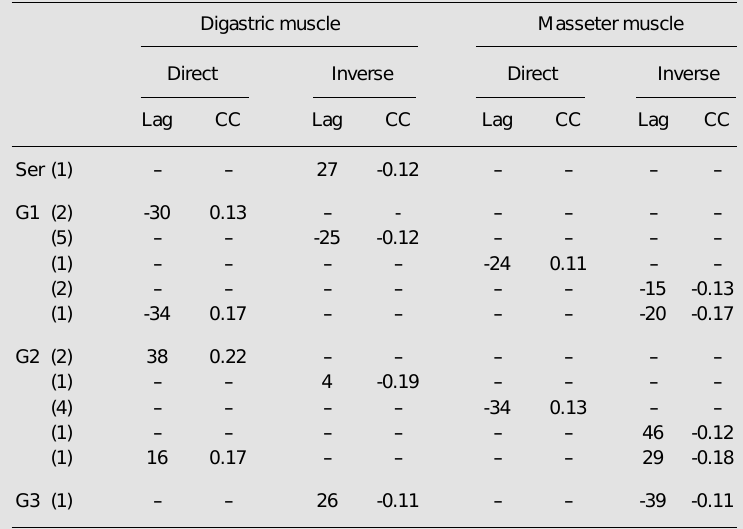
Table 3. Median of the maximum neuron-muscle cross-correlation coefficients and median of their respective lag times (in